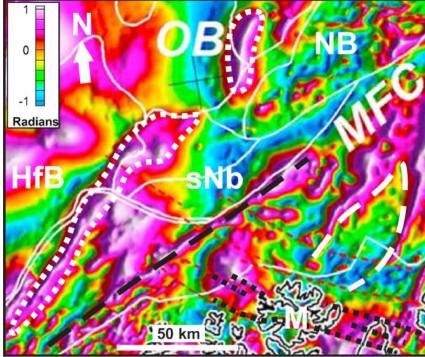
Figure 4. Enlargement of offshore tilt-derivative aeromagnetic data published by Gernigon et al. (2014). The white dashed line on the eastern Finnmark Platform represents a triangular- to rhomboid- shaped aeromagnetic low that coincides with a Carboniferous basin bounded by zigzag-shaped brittle faults (e.g., LVF). The dotted white lines on the western Finnmark Platform and on the north- ern flank of the southwesternmost basin represent ENE–WSW- to NE–SW-trending ridges of magnetic basement rocks. The dashed black line represents a linear, NE–SW-trending, high positive aero- magnetic anomaly that has been tied to the occurrence of the main segment of the MFC (see Indrevær et al., 2013). Dolerite dykes in- truded along WNW–ESE-trending segments of the TKFZ are shown by dotted black lines. Dashed red lines are the interpretation from Gernigon et al. (2014). See Fig. 1 for